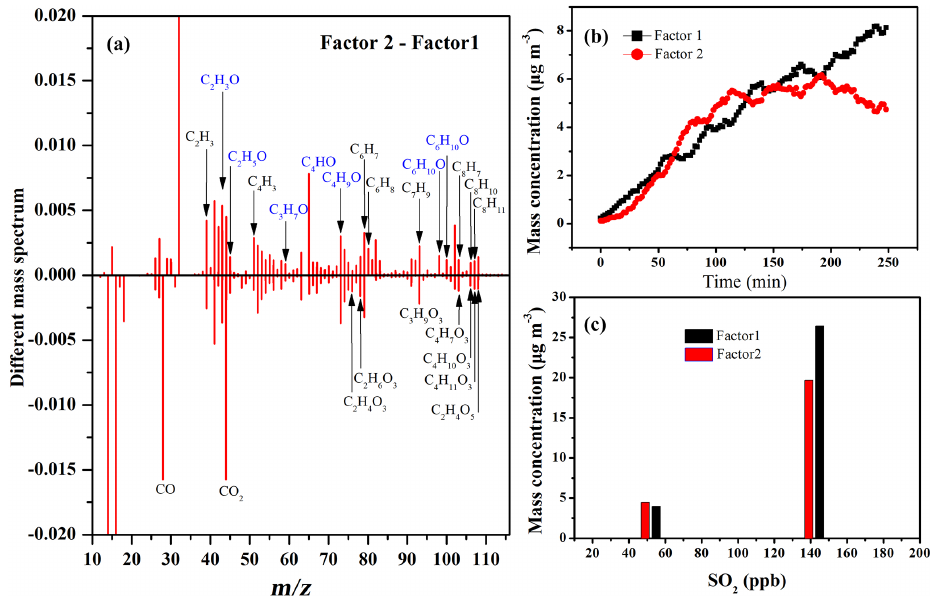
Figure 3. Two-factor solutions for PMF analyses of SOA under different SO 2 concentrations: (a) different mass spectra between two factors (Factor 2–Factor 1) at 135ppb SO 2 ; (b) time series of factor concentrations; (c) maximum concentration of two factors at 55 and 135ppb SO 2